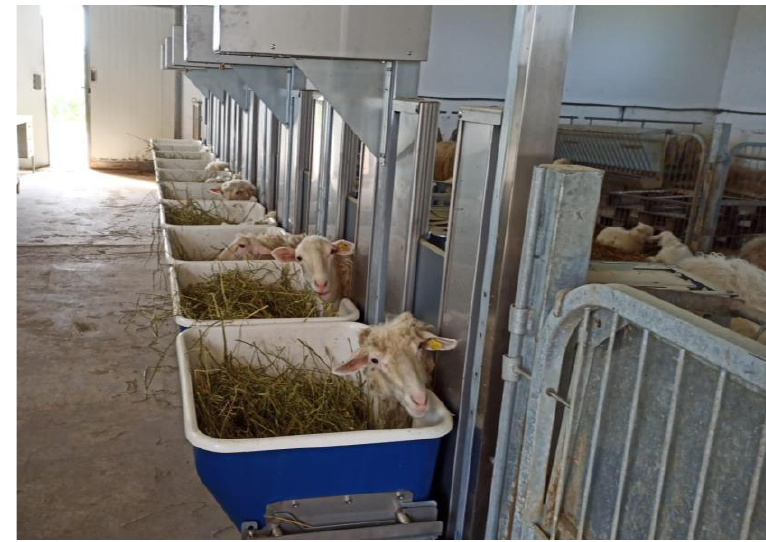
Figure 1. Automatic feeding systems at the experimental farm of the Dipartimento di Agraria, University of Sassari.